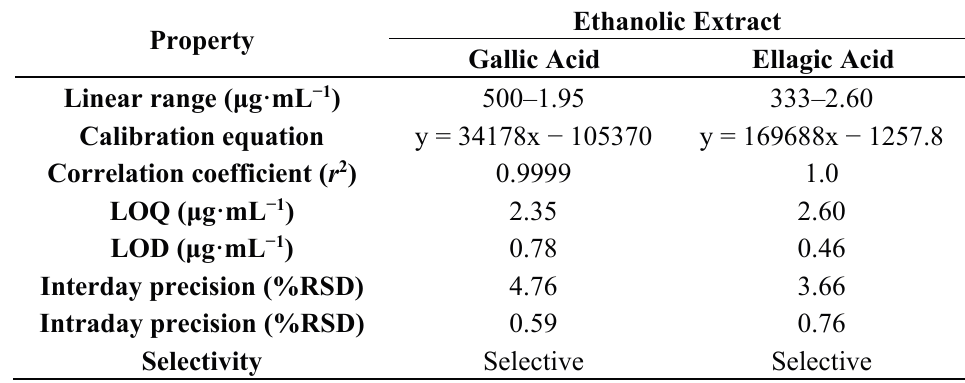
Table 2. Summary of validation data for ethanolic extract from the stem bark of C . ferrea .